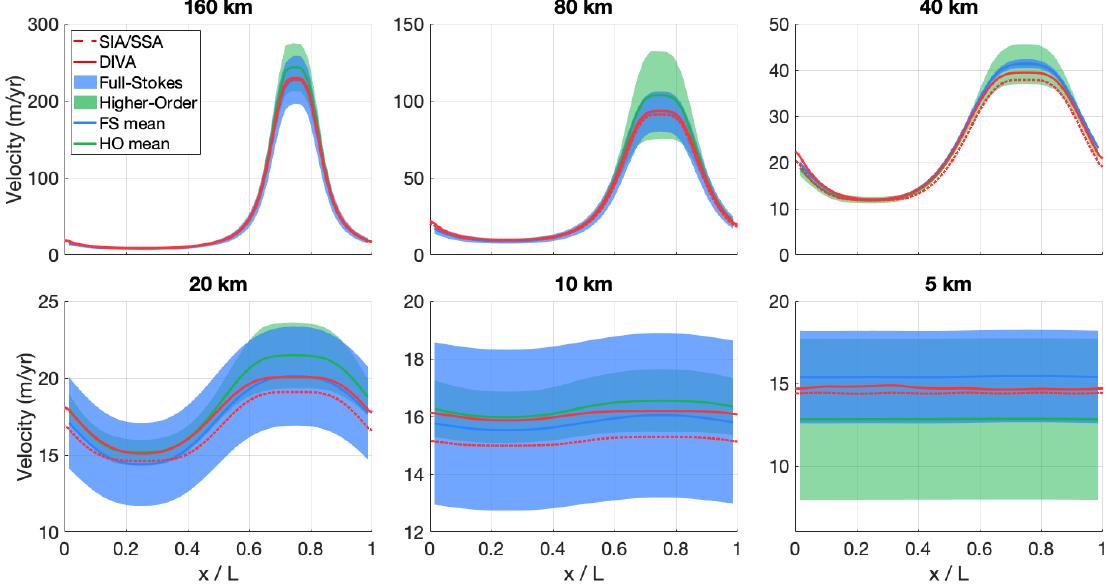
Figure B4. Modelled surface velocity transects for all versions of ISMIP-HOM experiment D (infinite ice slab on a sloping bed with oscillating friction in one direction), calculated with both the old hybrid SIA/SSA solver (dashed red line) and the new DIVA solver (solid red line). The results of the higher-order models (green) and the full-Stokes models (blue) that participated in ISMIP-HOM are shown for